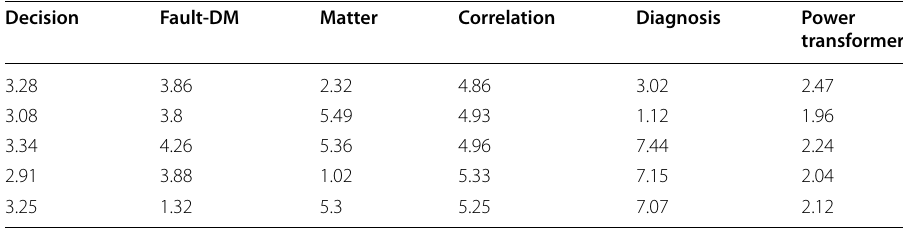
Table 4 Reduced a variety of complicated control time